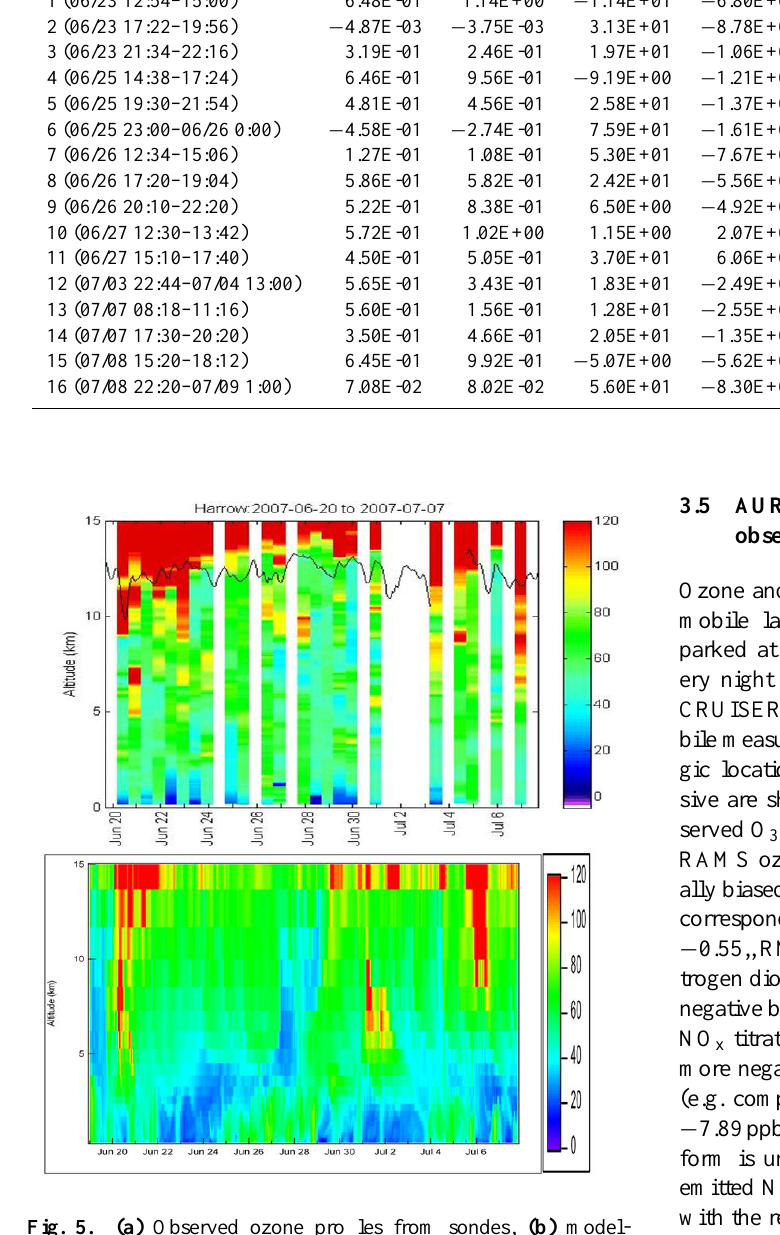
Fig. 5. (a) Observed ozone profiles from sondes, (b) model- simulated ozone